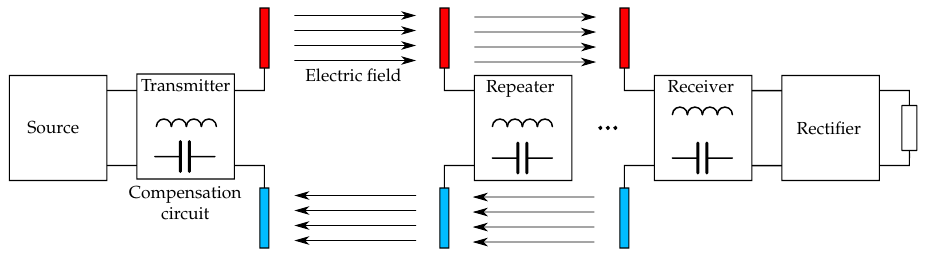
Figure 12. Electric field